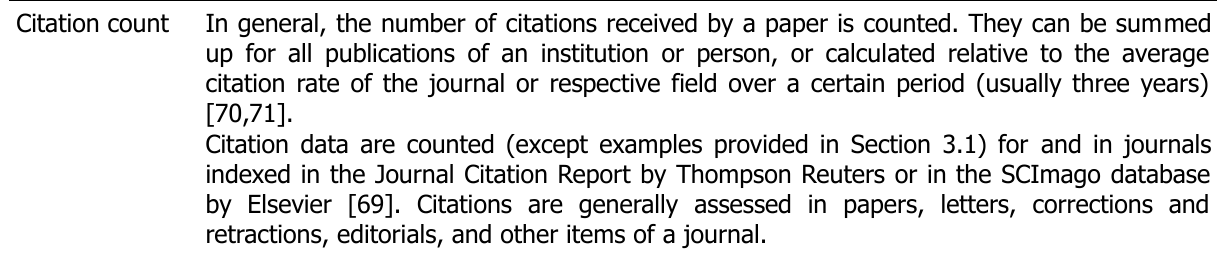
Table 1. Indicators that are frequently used for scientific impact